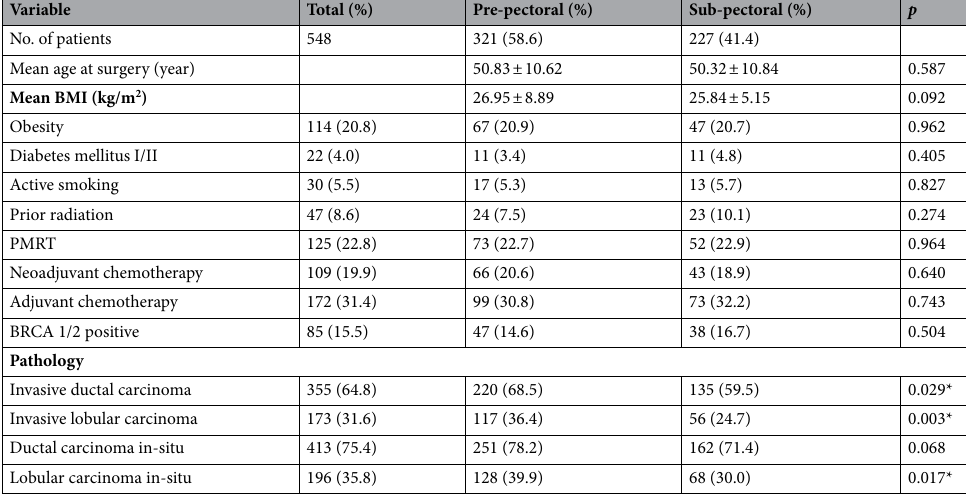
Table 1. Patient demographics and oncologic characteristics. This table compares the demographics and oncologic characteristics of patients who underwent sub-pectoral reconstruction versus patients who underwent pre-pectoral reconstruction in 2017 through 2020. The two cohorts of patients significantly differ in the incidence of invasive carcinomas and lobular carcinoma in-situ. Continuous variables were analyzed via independent two-tailed t-tests (95% confidence interval) and displayed with standard deviation values. Non- continuous variables were analyzed via Pearson’s chi square. BMI body mass index, PMRT post-mastectomy radiation therapy, BRCA breast cancer gene; ± SD; 95% CI. Obesity defined as BMI ≥ 30. *Statistically significant ( p < 0.05).